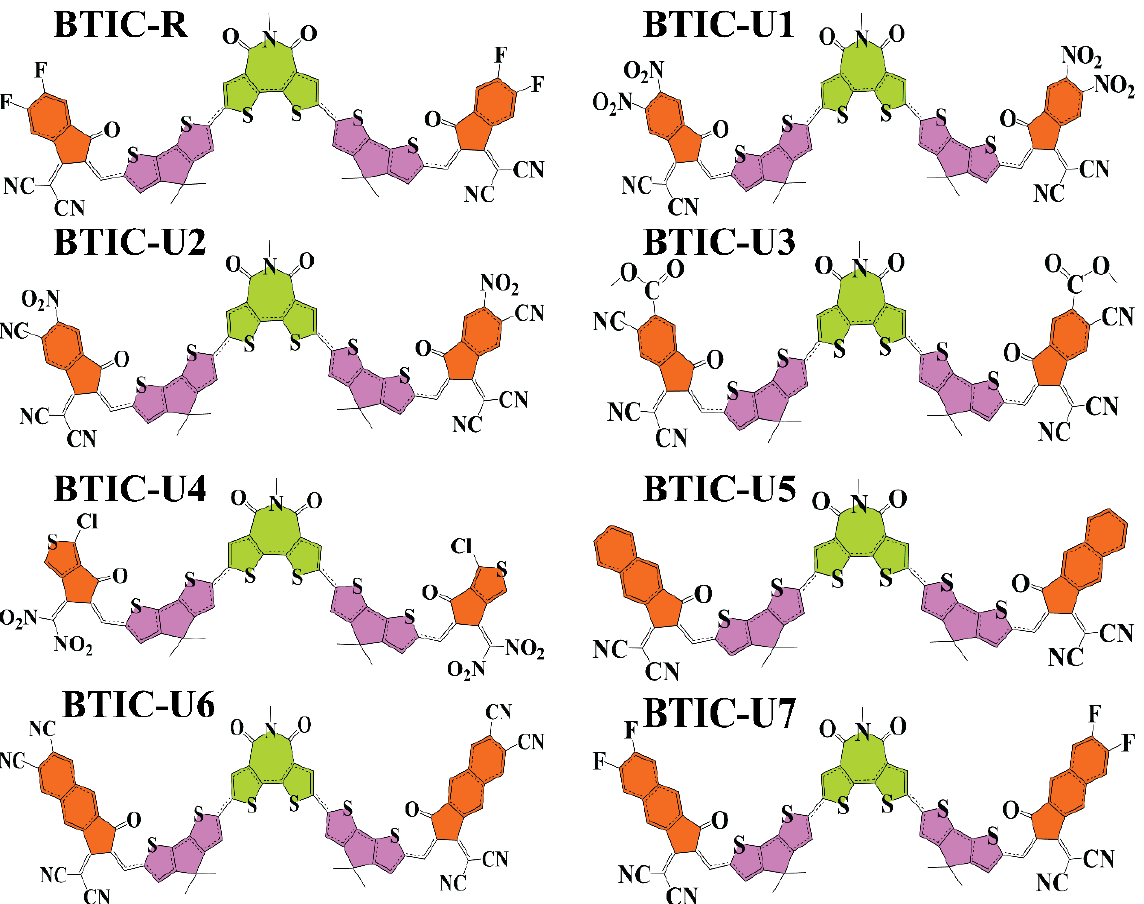
Figure 1. ChemDraw structures of BTIC-R and BTIC-U1 to BTIC-U7 molecules.